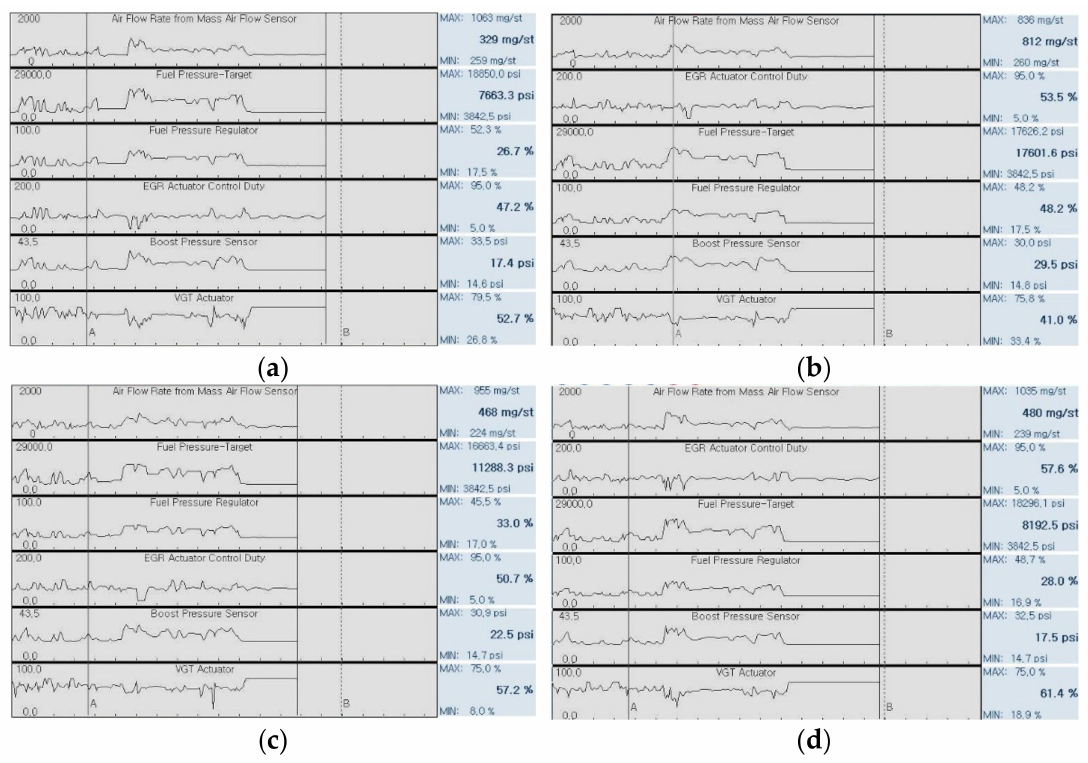
Figure 8. GDS raw signal measured during KD-147 driving mode for 4 types of DPF sample. ( a ) Normal ( b ) Crack ( c ) Hollow ( d )